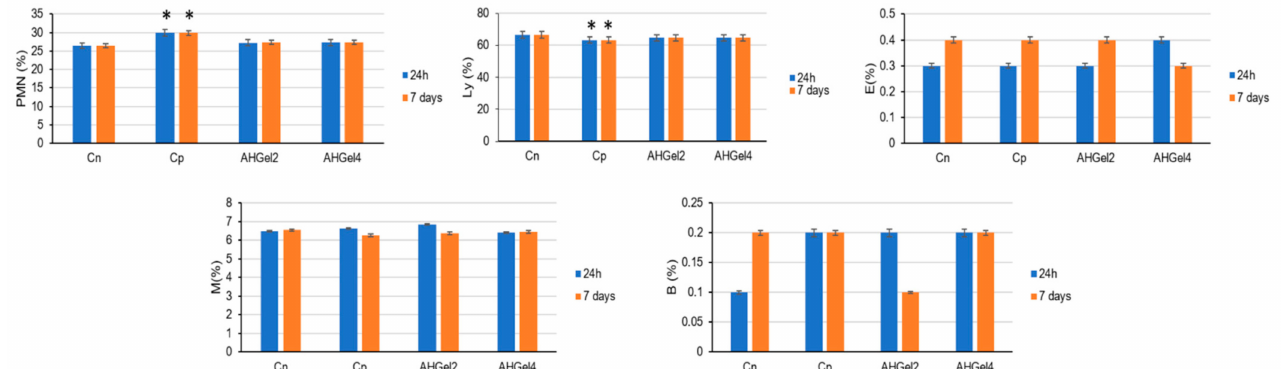
Figure 9. Effects of subcutaneous implantation of Amox-loaded hydrogels on leukocyte formula elements. Values are presented as mean ± S.D. of the percentage of leukocyte formula elements (PMN–polymorphonuclear neutrophils, Ly–lymphocytes, E–eosinophils, M–monocytes, B–basophils) using six laboratory animals per batch. * p < 0.05 compared to